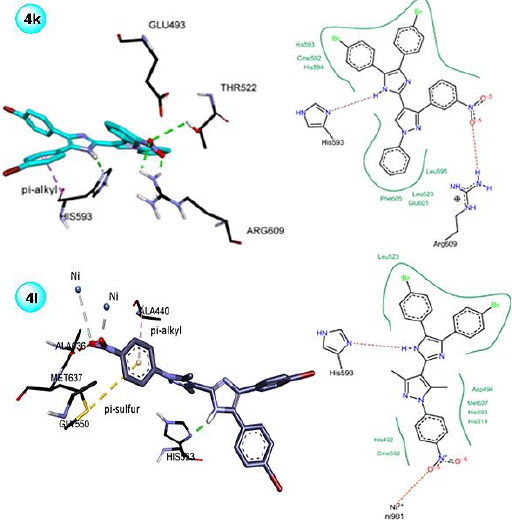
Figure 15. 3D and 2D Interactions of compounds 165k and 165l with the amino acids of 4GY7. Image adapted from Chaudhry et al. [164].